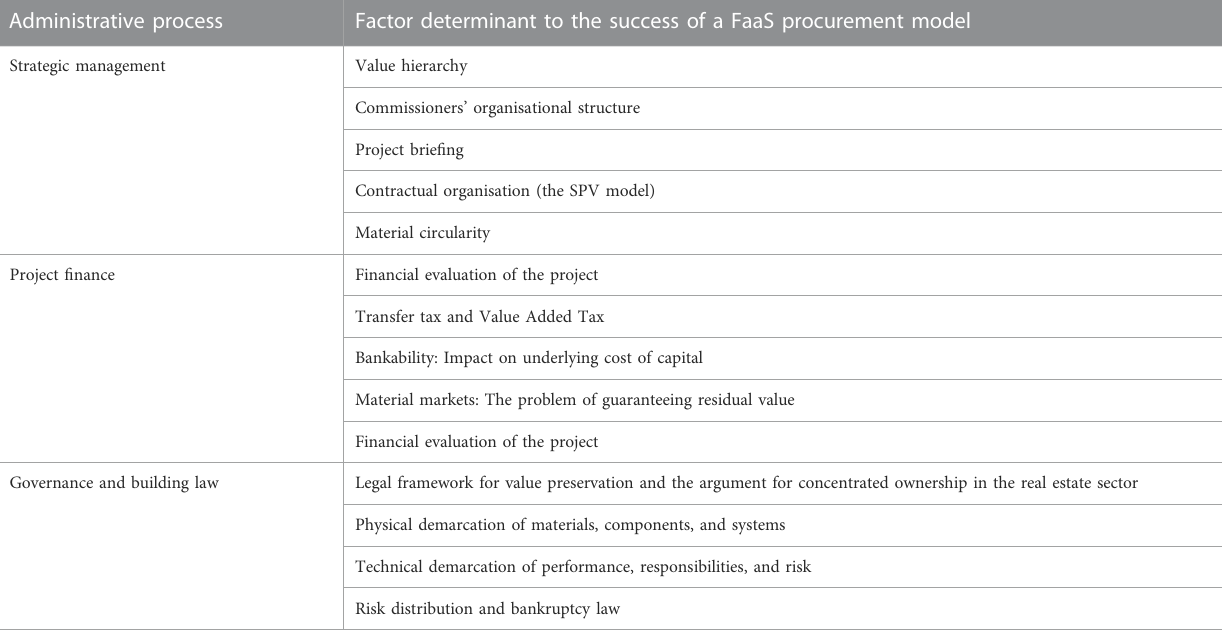
TABLE 1 List of factors determinant to the success of a FaaS procurement model 1 . Administrative